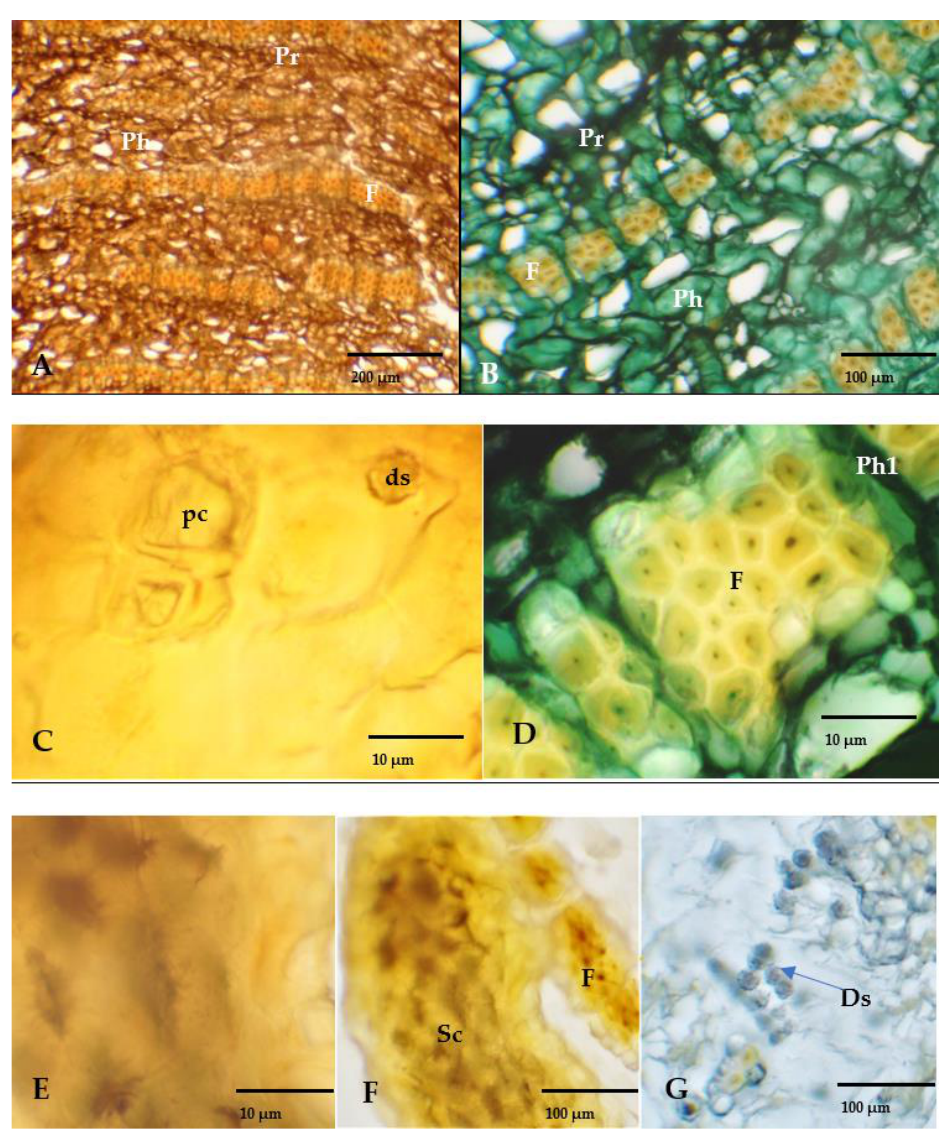
Figure 2. The histo-anatomical aspects of the older bark of Quercus robur in the transverse section. ( A ) Rhytidome (old bark) includes various periderms (Pr), dead secondary phloem (Ph) between them and sclerenchimatic fibers and sclereids (FS); ( B ) portions of rhytidome — periderm stained green with iodine; ( C ) chambered crystalliferous cells with prismatic crystals (pc) and druses (ds); ( D ) detail with sclerenchimatic fibers ( F ) and uniseriate phloem rays (Ph1); ( E ) sclereids (Sc); ( F ) sclereids group and fibers ( F ); ( G ) druses (ds).